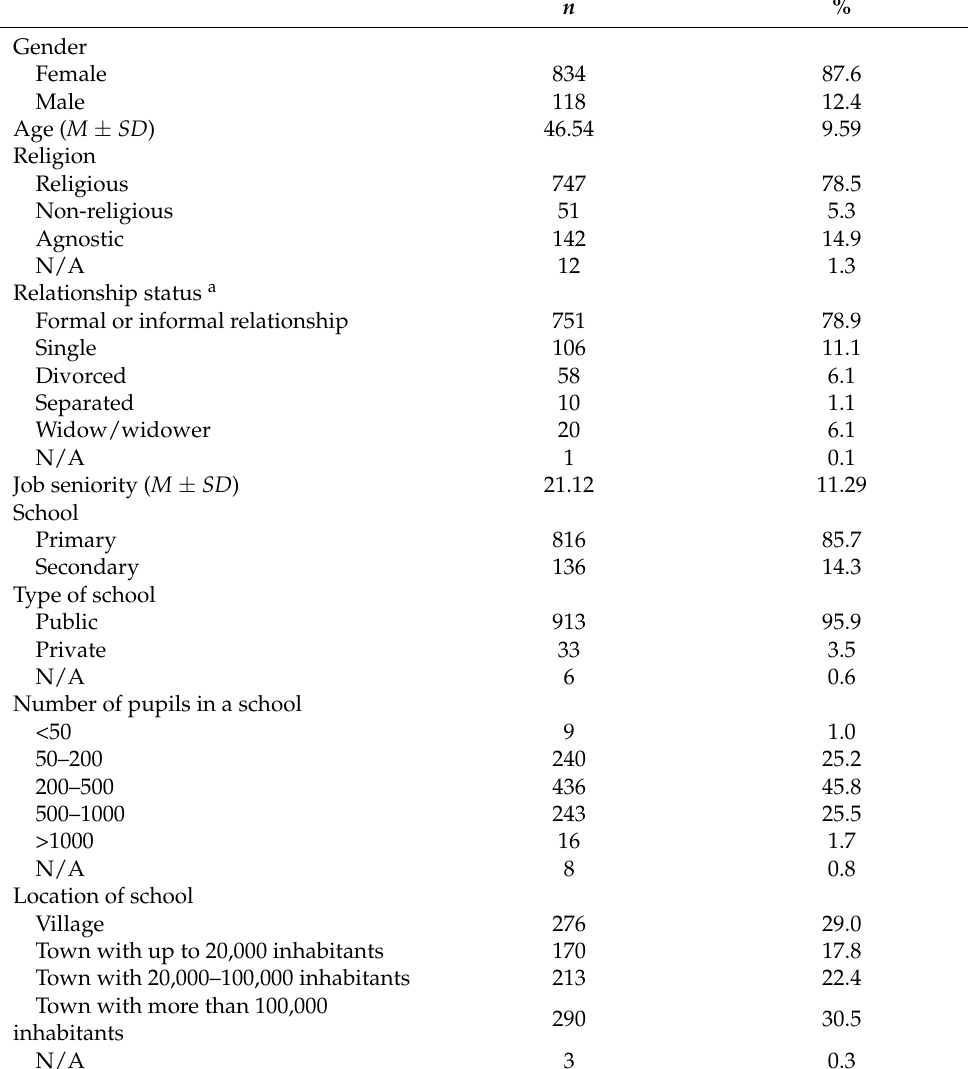
Table 1. Sociodemographic characteristics of the